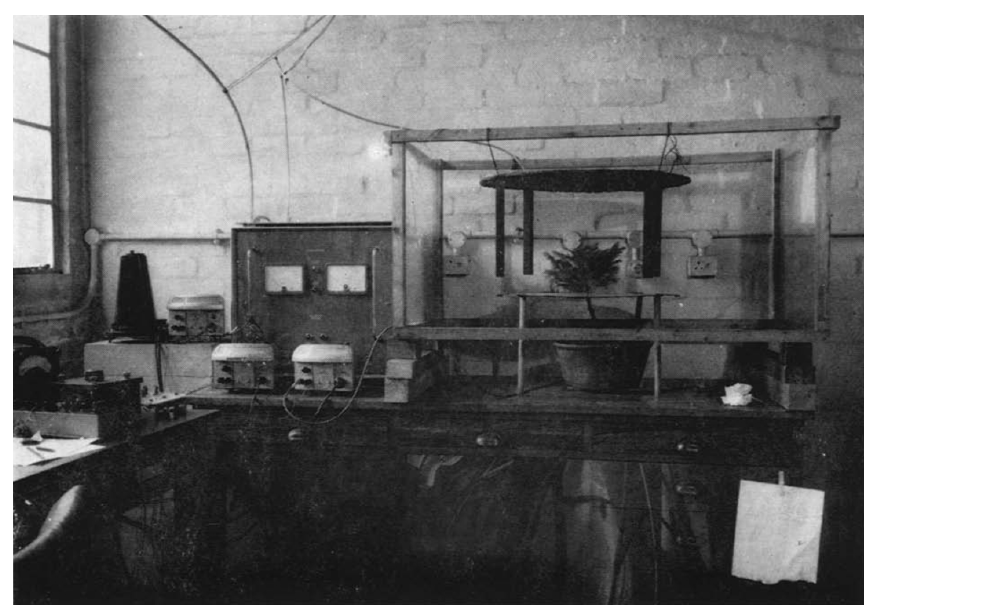
Figure 3. Experimental configuration used by Jhawar and Chalmers in 1967 (no. 84) (reproduced with permission from Elsevier). The spruce tree, seen to the right of the image, is placed between a set of electrodes to apply an electric field, and the current flow is